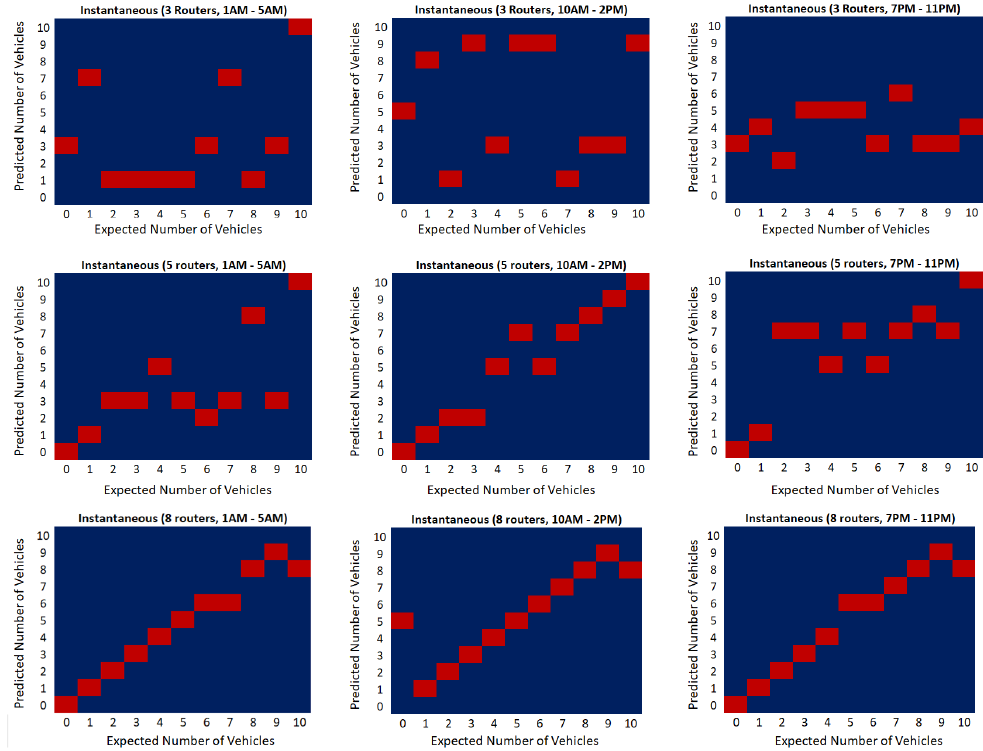
Figure 4. POVD instantaneous prediction employing 3- (first row), 5- (second row), and 8-router (third row) deployment schemes taken at three different times of the